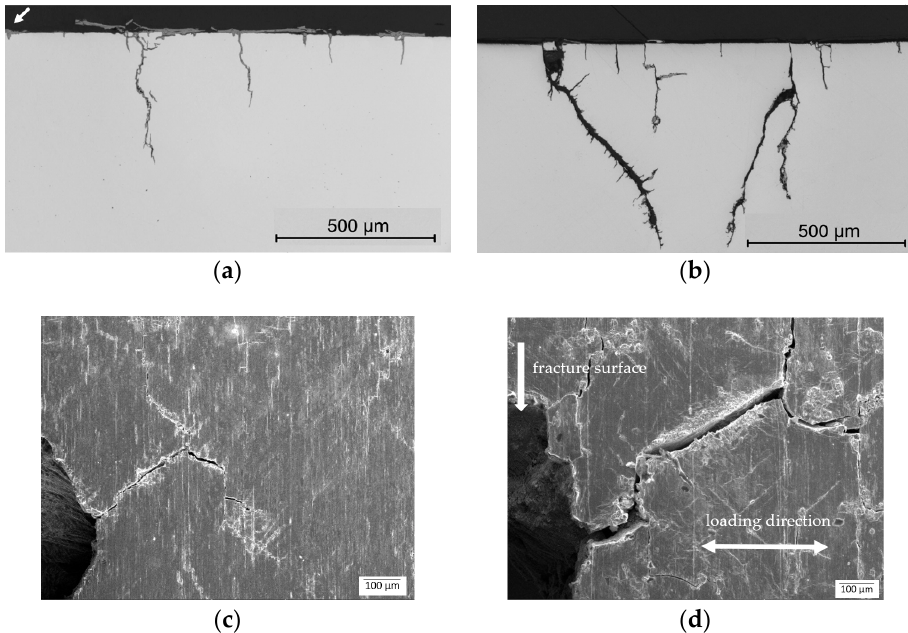
Figure 18. Optical micrographs of the longitudinal sections showing the regions marked by yellow rectangles in Figure 17c,d in a higher magnification. ( a ) LCF ±0.5% and ( b ) RF ±0.4%. SEM micrographs of the shell surface of the LCF and RF specimens, at the edge of the main crack, ( c ) LCF ±0.5% and ( d ) RF ±0.4%.